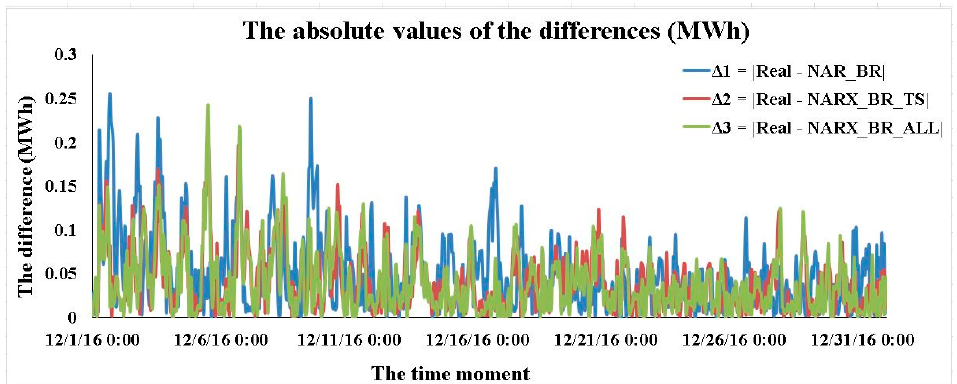
Figure 20. The absolute values of the differences between the real consumption and each of the three forecasted ones. forecasted ones.